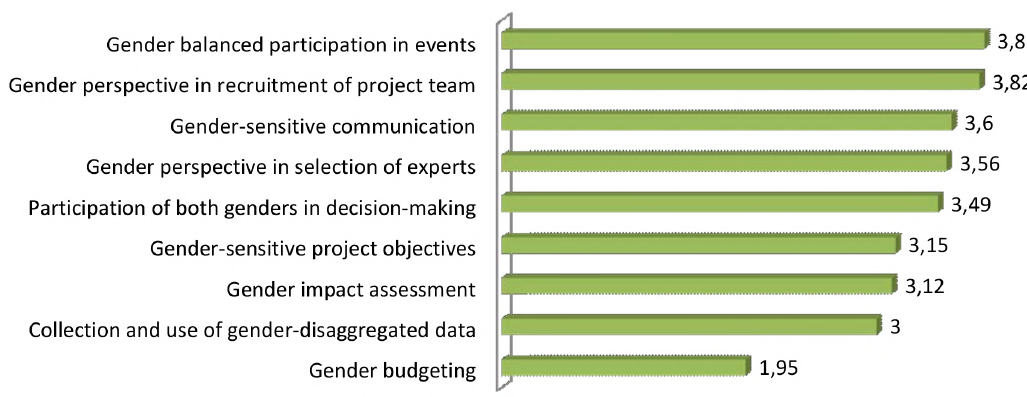
Figure 68: Presentation of paper